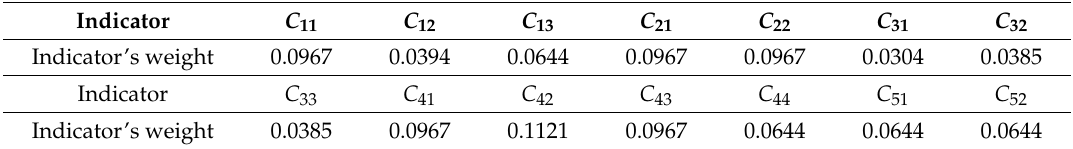
Table 6. Weight of each indicator.